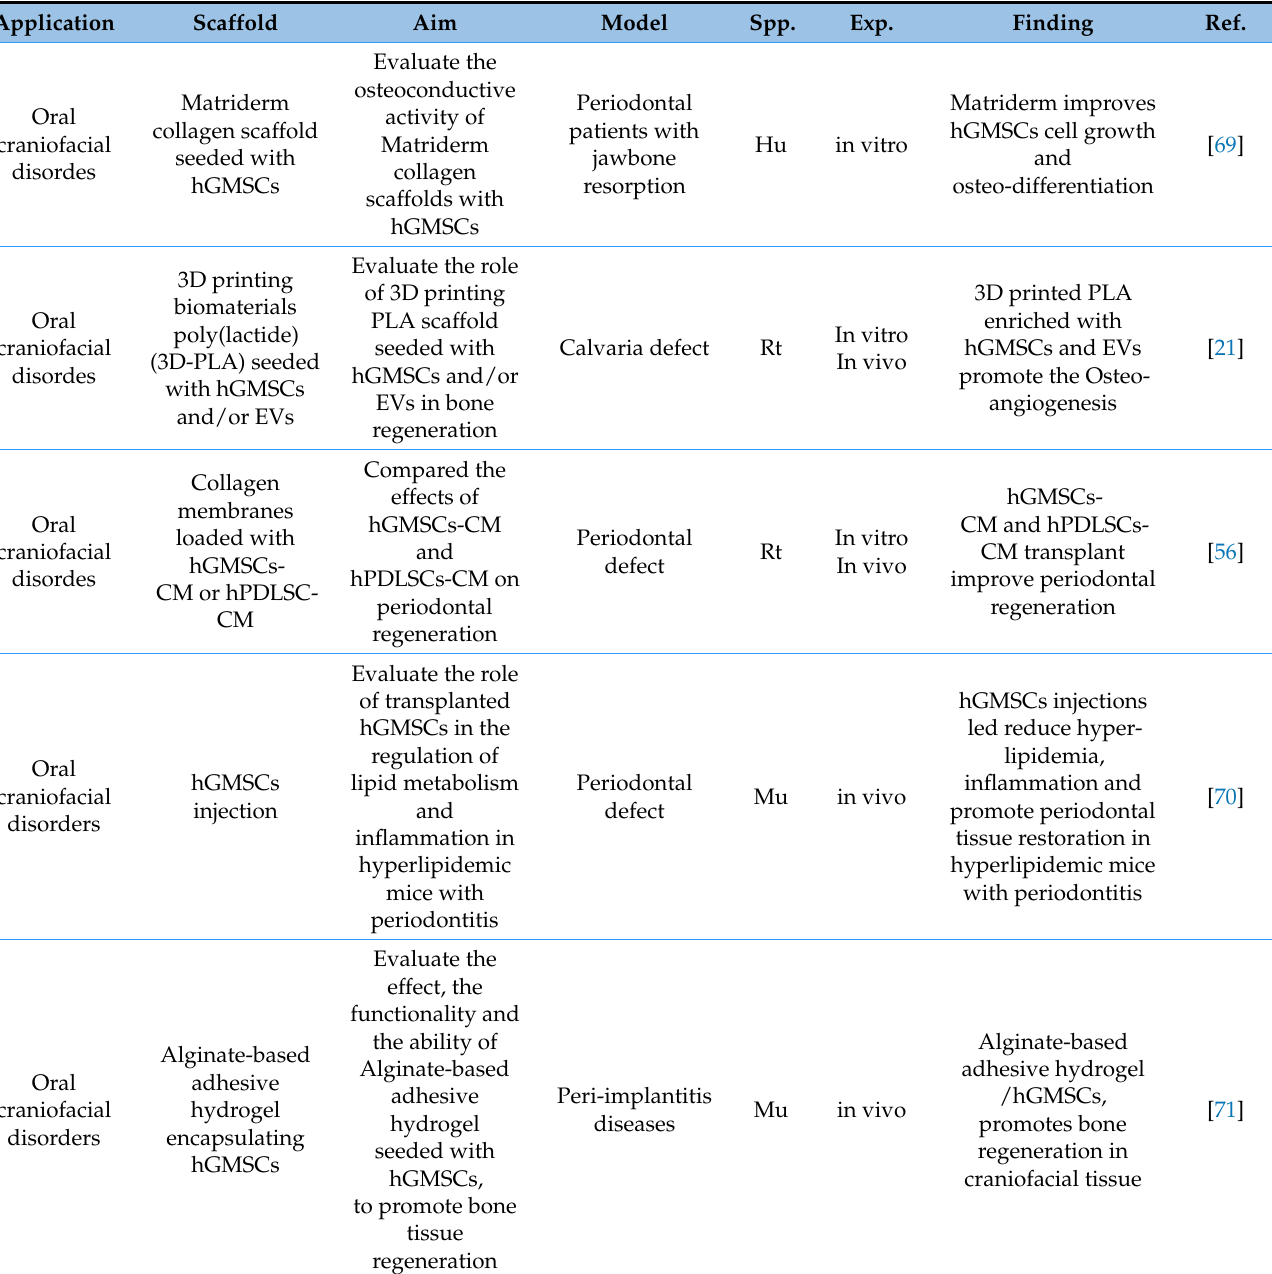
Table 4. hGMSCs application in regenerative